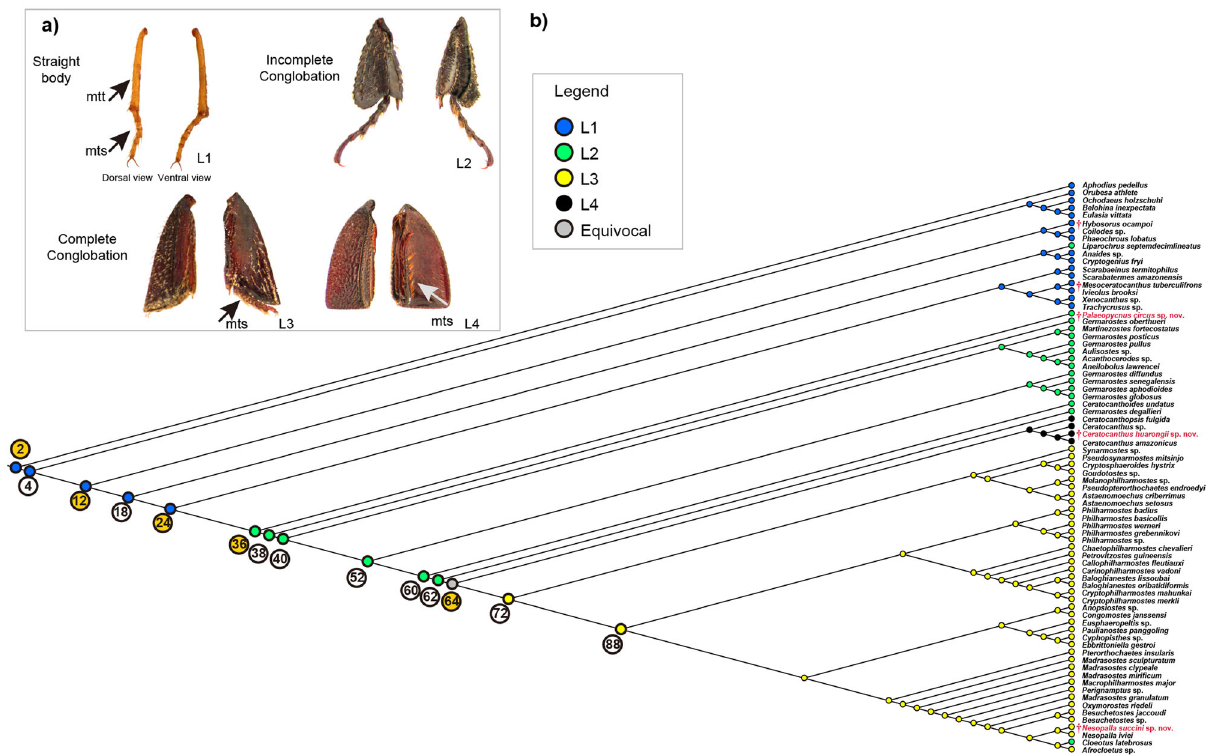
Fig. 5 Evolution of metatibiae in Ceratocanthinae. a Comparative morphology of the metatibiae; mtt: metatibia, mts: metatarsus. L1: rod-like metatibia ( Ivieolus brooksi ), L2: unconstrained triangular metatibia ( Germarostes globosus ), L3: interlocking triangular metatibia ( Astaenomoechus setosus ), L4: interlocking triangular metatibia with a tarsal groove ( Ceratocanthus amazonicus ). b Ancestral state reconstruction of the